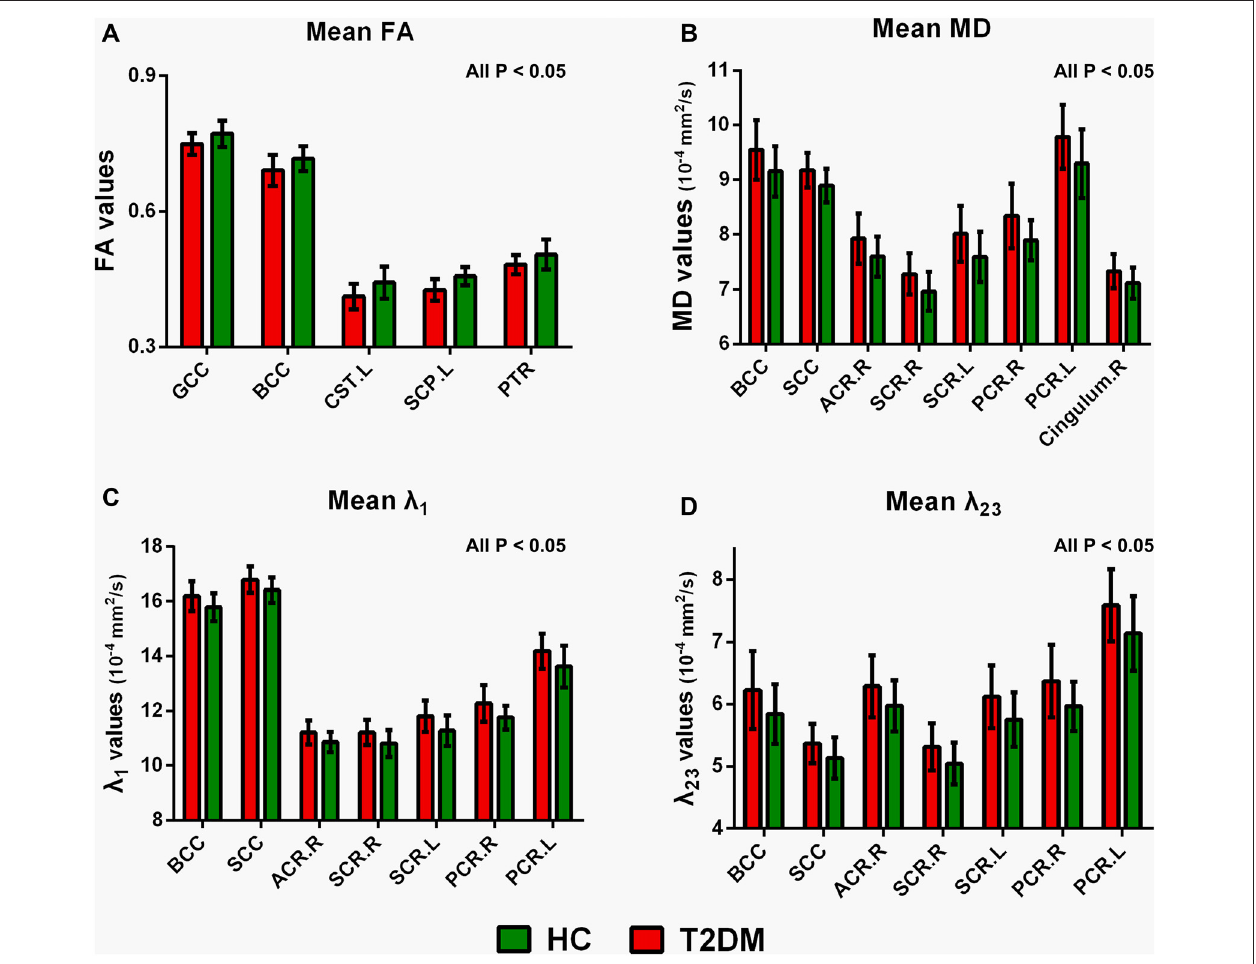
FIGURE 3 | Mean diffusion metrics and group differences of region of interests (ROIs) analysis between T2DM and HC groups. (A) Regions with decreased FA in T2DM groups; (B) regions with increased MD in T2DM groups; (C) regions with increased λ 1 in T2DM groups; (D) regions with increased λ 23 in T2DM patients. All the ROIs showed in the figure were significantly different (all P < 0.05). GCC, genu of corpus callosum; BCC, body of corpus callosum; SCC, splenium of corpus callosum; CST, corticospinal tract. SCP, superior cerebellar peduncle; PTR, posterior thalamic radiation. ACR, anterior corona radiata. PCR, posterior corona radiata. SCR, superior corona radiata. R, right, L,